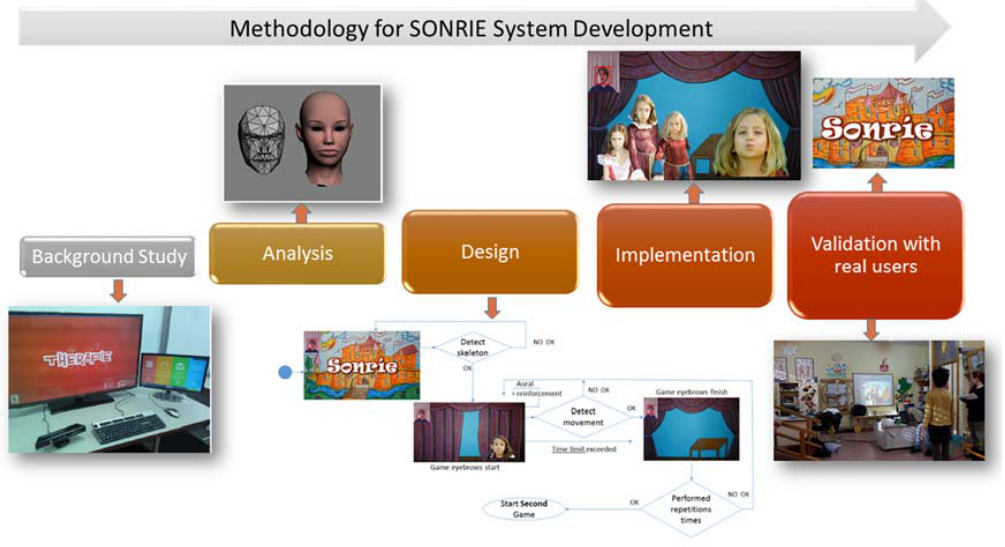
Figure 1. Work methodology used for the construction of SONRIE.